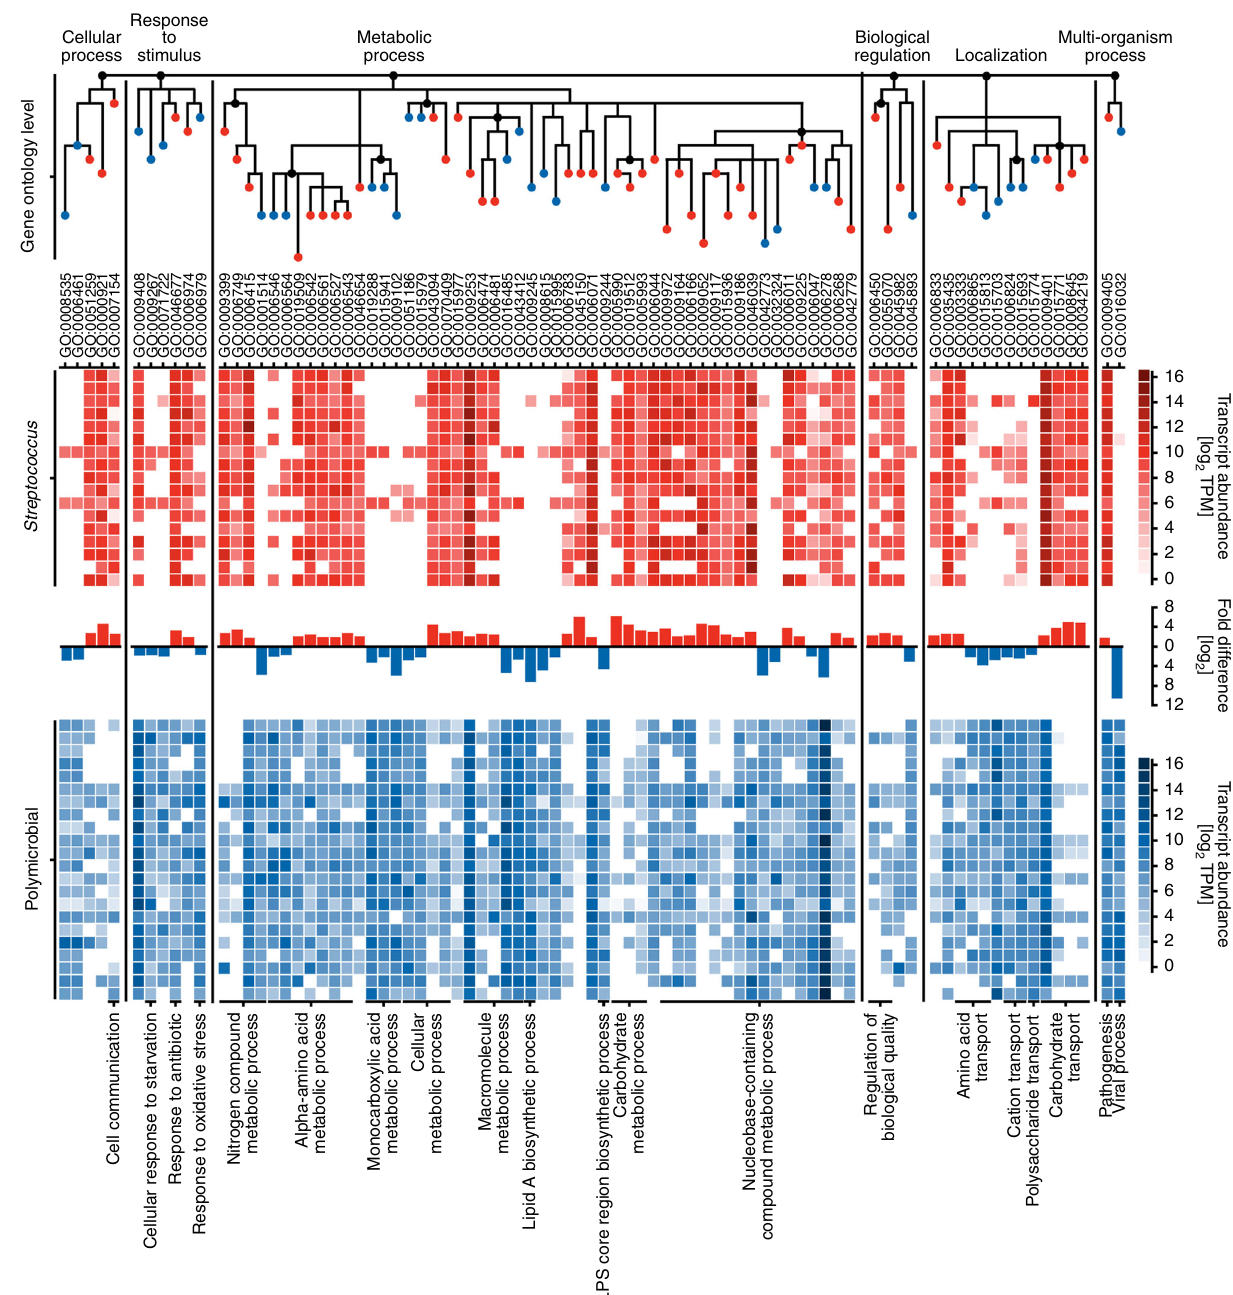
Fig. 3 Streptococcus spp. and polymicrobial communities express different functionalities that facilitate nutrient acquisition and sustained in fl ammation. GO terms (root: biological process) with signi fi cantly higher associated gene expression in the transcriptional pro fi le of Streptococcus spp. (red, n = 17) or polymicrobial communities (blue, n = 22) during NSTIs (Benjamini – Hochberg adjusted p -value ≤ 0.05 Kruskal – Wallis test, log 2 fold difference ≥ 2) are shown. The heat map depicts summed sample-wise transcript abundance (log 2 TPM) of genes associated with each GO term. The dendrogram depicts the GO hierarchy of all visualized GO terms. GO term clusters (labeled below the graph) are based on common parent terms. Nodes are hierarchically arranged to re fl ect distance to the root and their color indicates the pathobiome with the higher associated average expression. Source data are provided in Supplementary Data